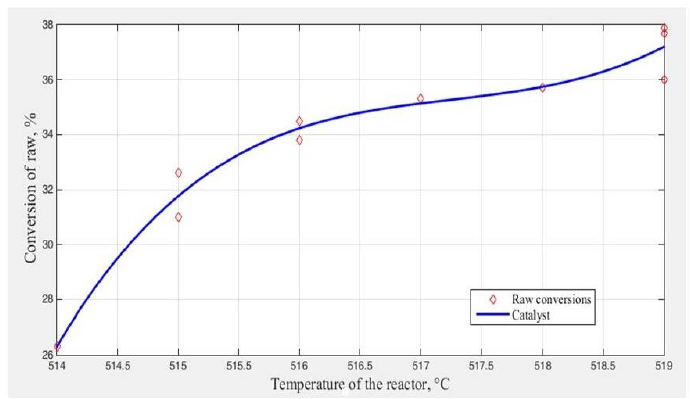
Figure 4. Dependence of conversion of raw materials on temperature of